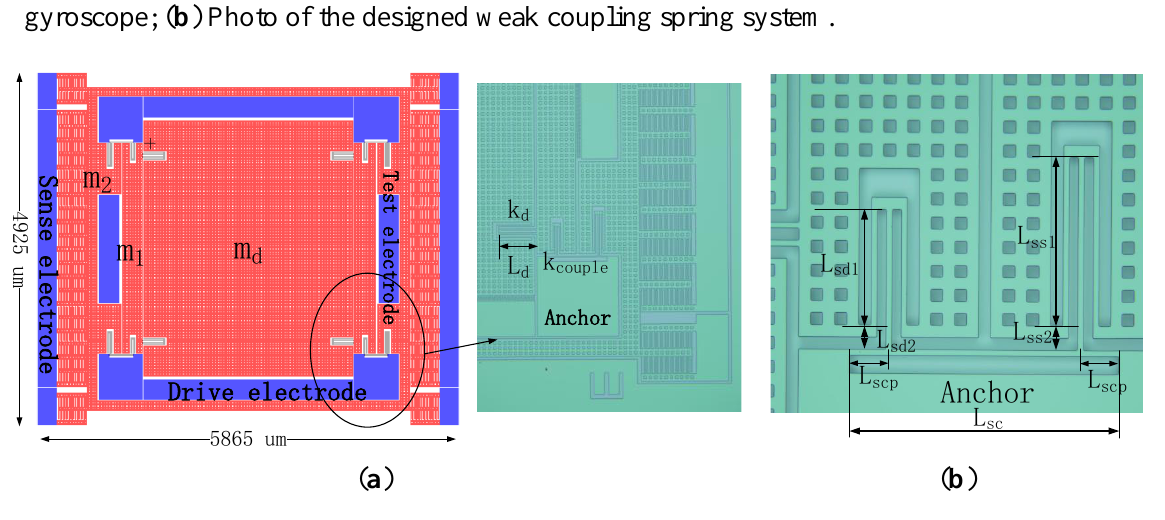
Figure 5. Layout of the designed gyroscope. ( a ) Layout and partial photo of the designed gyroscope; ( b ) Photo of the designed weak coupling spring system.